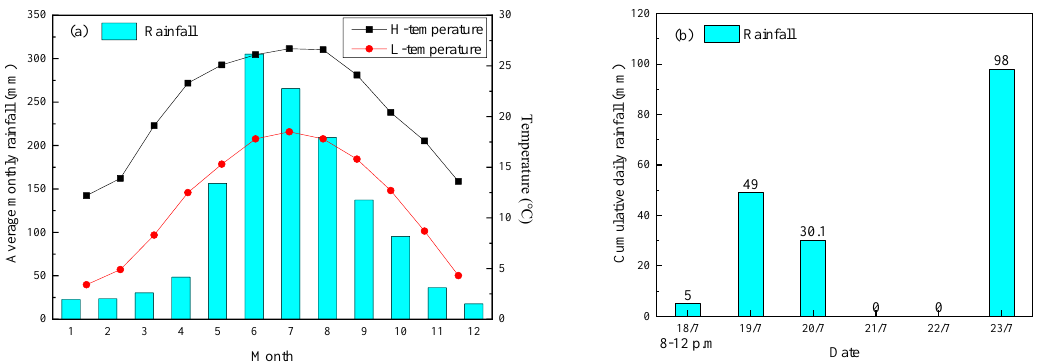
Figure 7. ( a ) Average monthly rainfall, highest temperature (H-temperature), and lowest temperature (L-temperature) in Pingdi village and ( b ) the rainfall prior to the landslide.